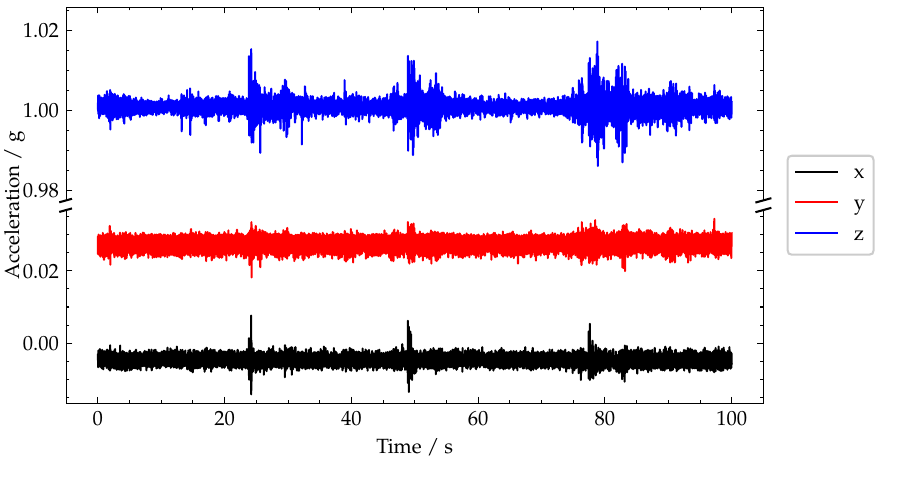
Figure 18. Plot of recorded acceleration